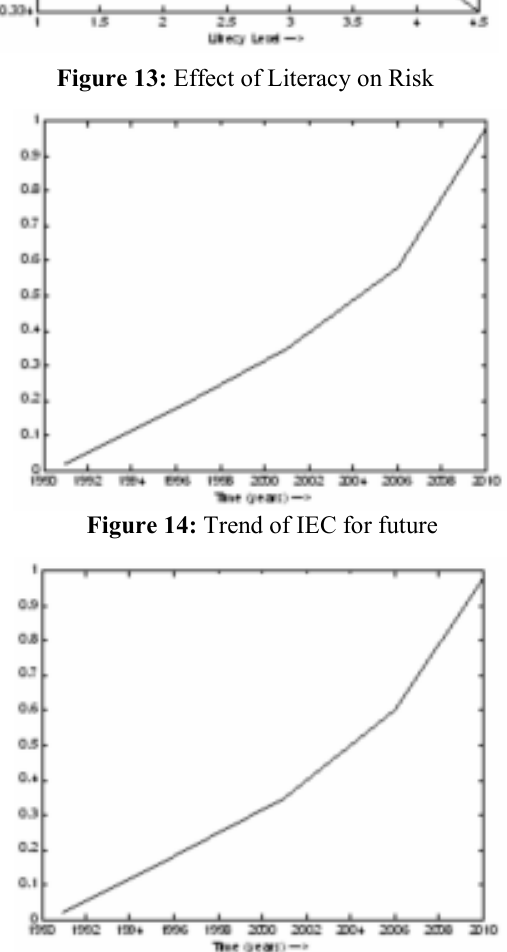
Figure 11: Risk of HIV infections